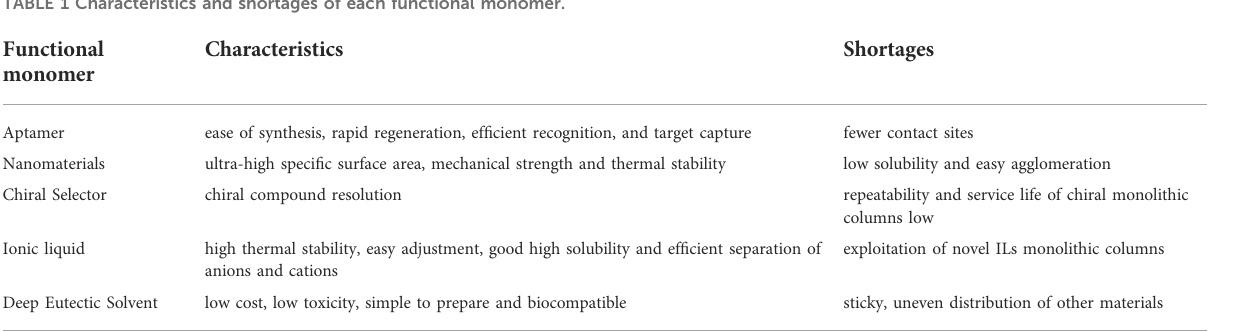
TABLE 1 Characteristics and shortages of each functional